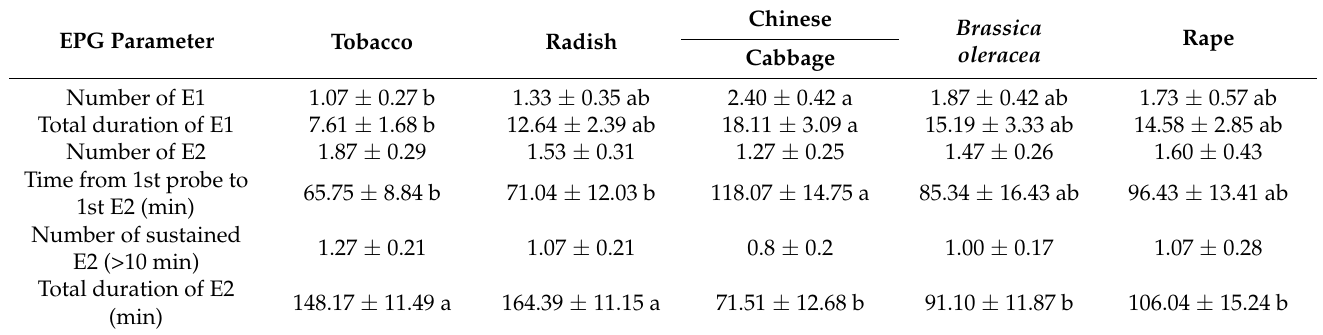
Table 2. EPG parameters of M. persicae feeding on phloem phase of five host plants.